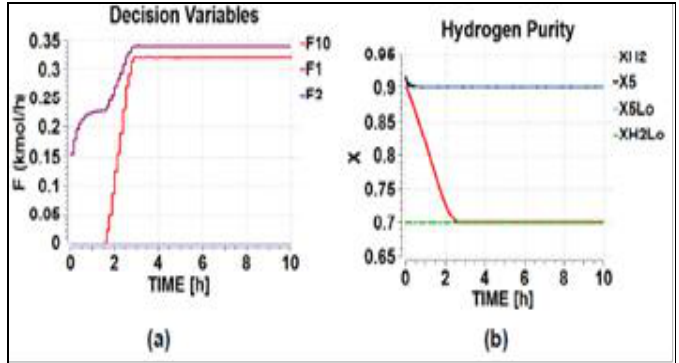
Figure 11: (a) Manipulated and (b) constrained variables. Source: Authors, (2018).